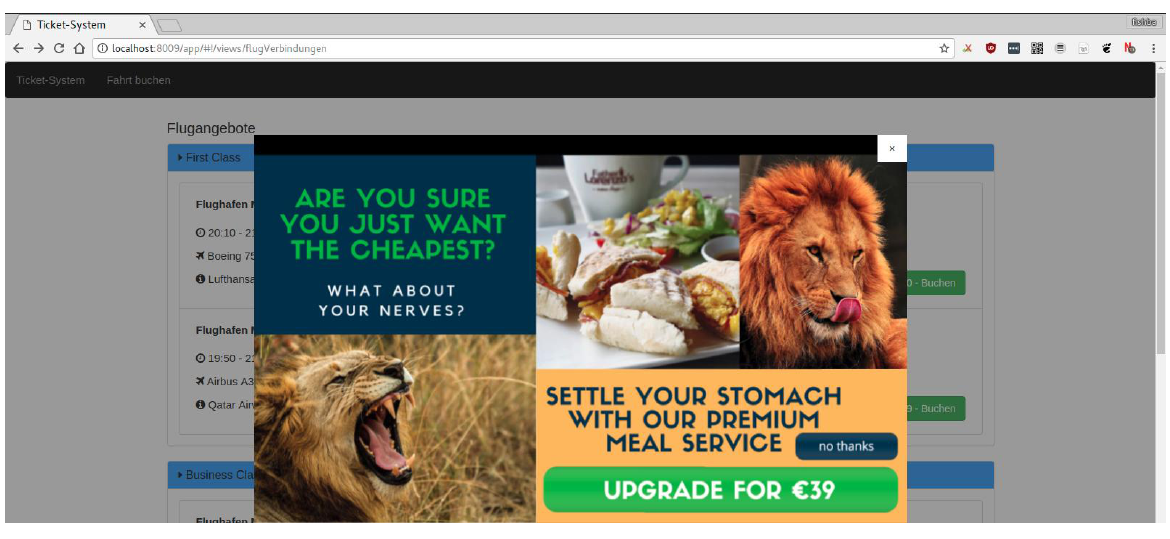
Figure 5. Offering an additional meal service